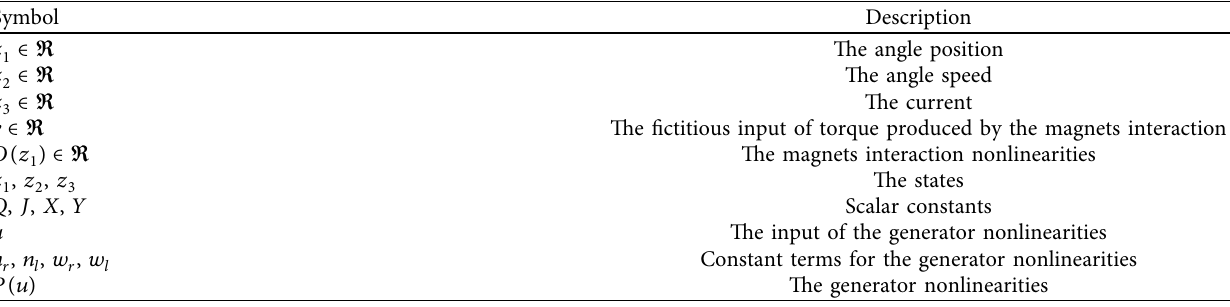
Table 3: Description of the mathematical model symbols.